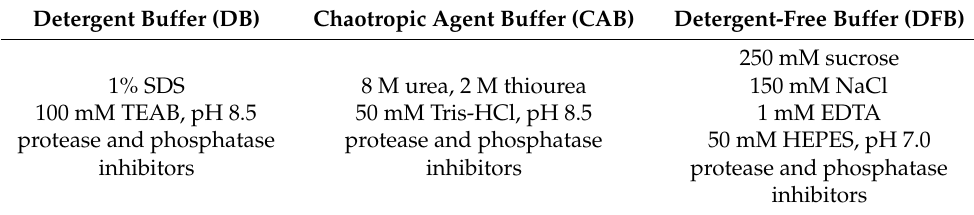
Table 1. Composition of homogenization buffers used in the